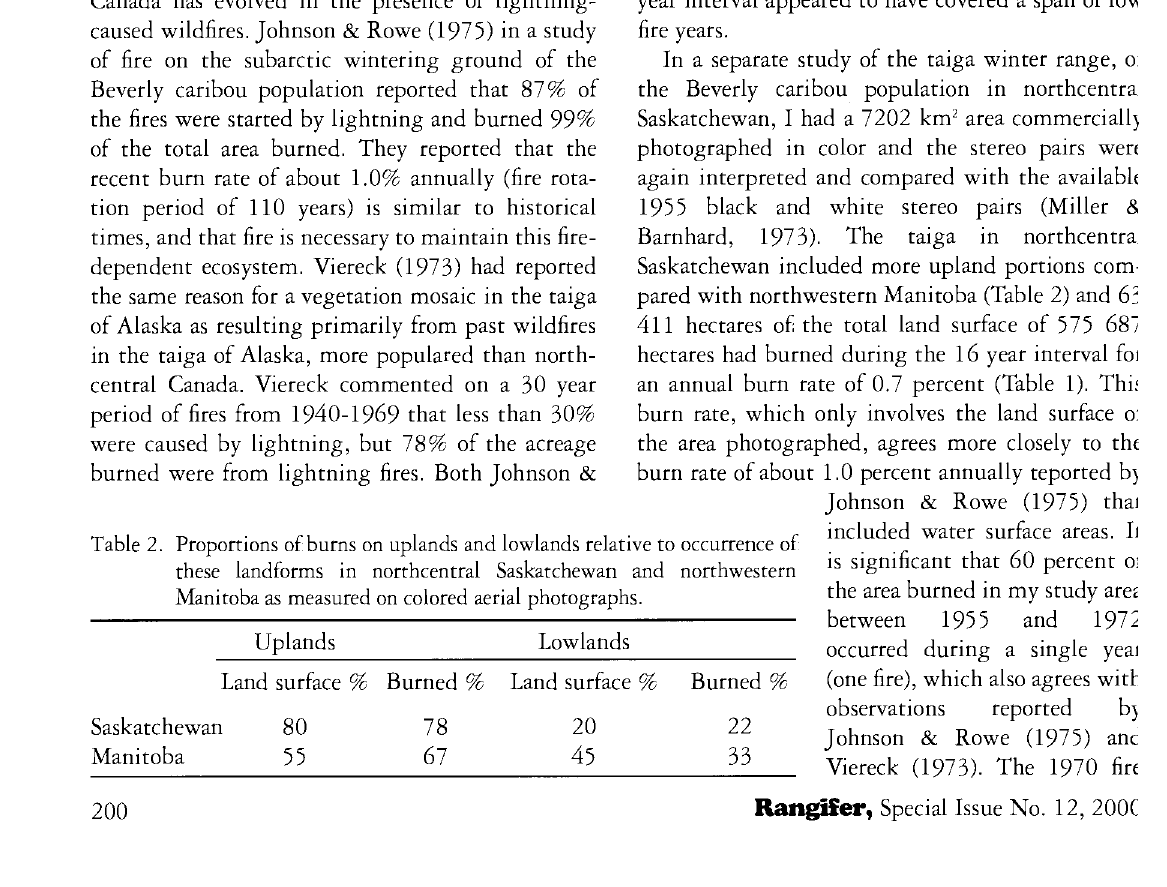
Table 2. Proportions of burns on uplands and lowlands relative to occurrence of Manitoba as measured on colored aerial